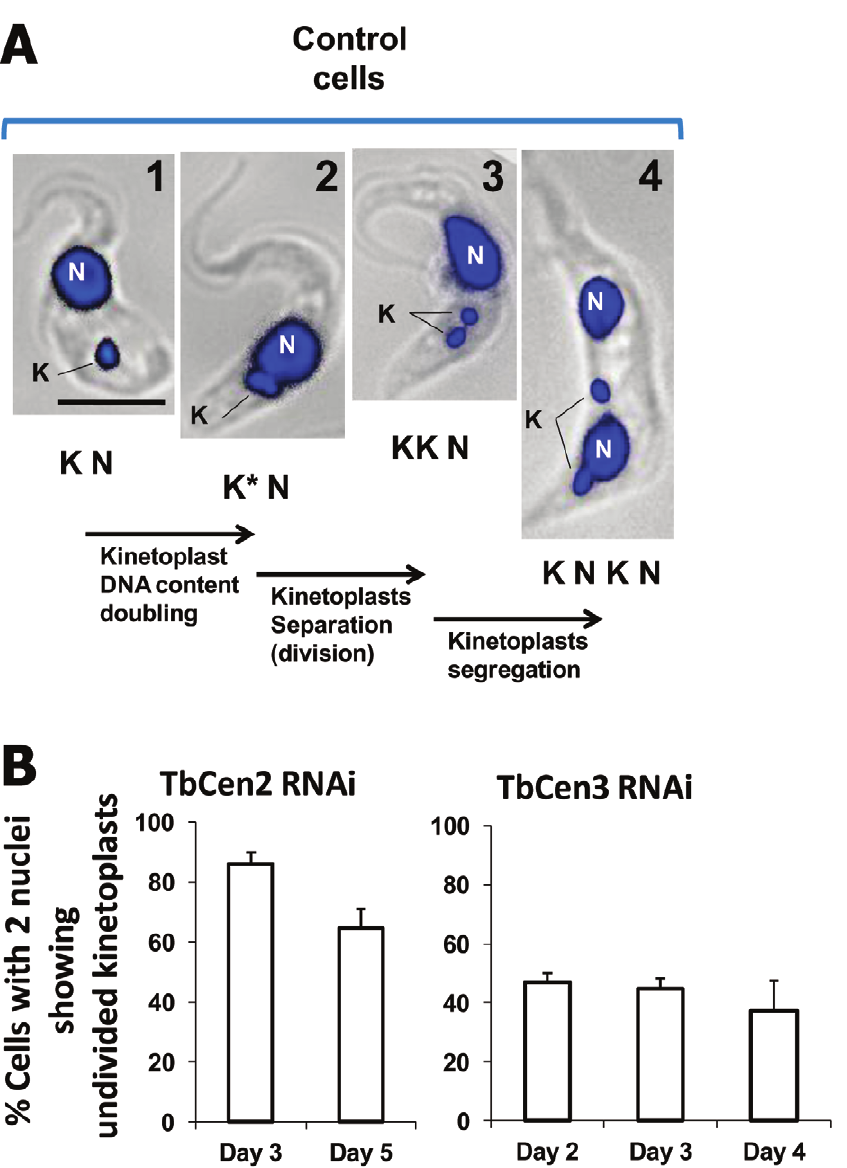
Figure 5. Sequence of organelle biogenesis and segregation in normal and RNAi cells. A : The control cells sequentially show duplication of DNA content from panel 1 to 2; division into two kinetoplasts from panel 2 to 3; segregation of the separated kinetoplasts to appropriate locations from panel 3 to 4. An, anterior end; K, kinetoplast; N, nucleus, Po, posterior end. Scale bar, 5 m m. B : Histogram showing the percent of TbCen2 and TbCen3 RNAi cells with undivided kinetoplasts in the two nucleated cells at different time points including day 3 for TbCen2 RNAi and day 2 for TbCen3 RNAi. For the TbCen2 and 3 RNAi, average 200 and 170 cells respectively were manually counted and analyzed during each time point. Data represent the means 6 SD of three independent